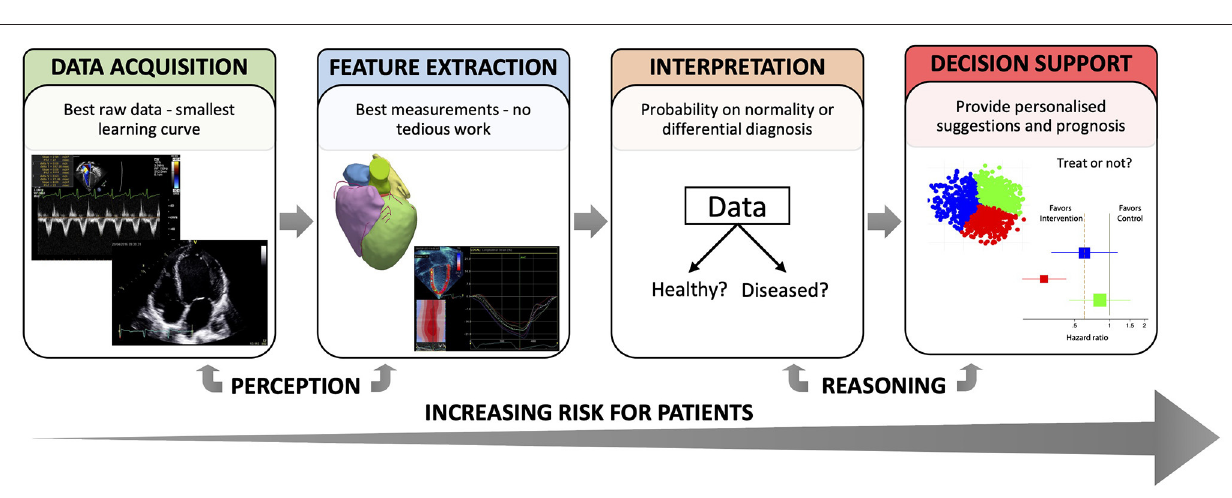
FIGURE 2 | Different tasks where ML can support clinical